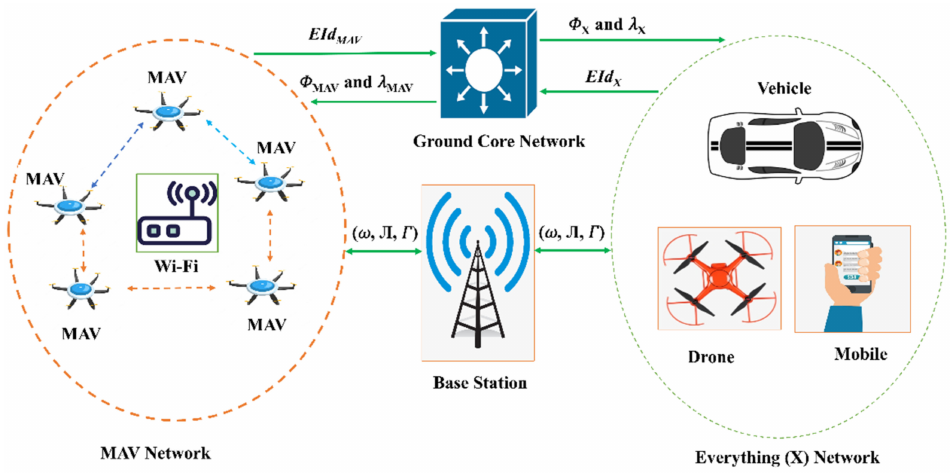
Figure 2. Network model of the proposed